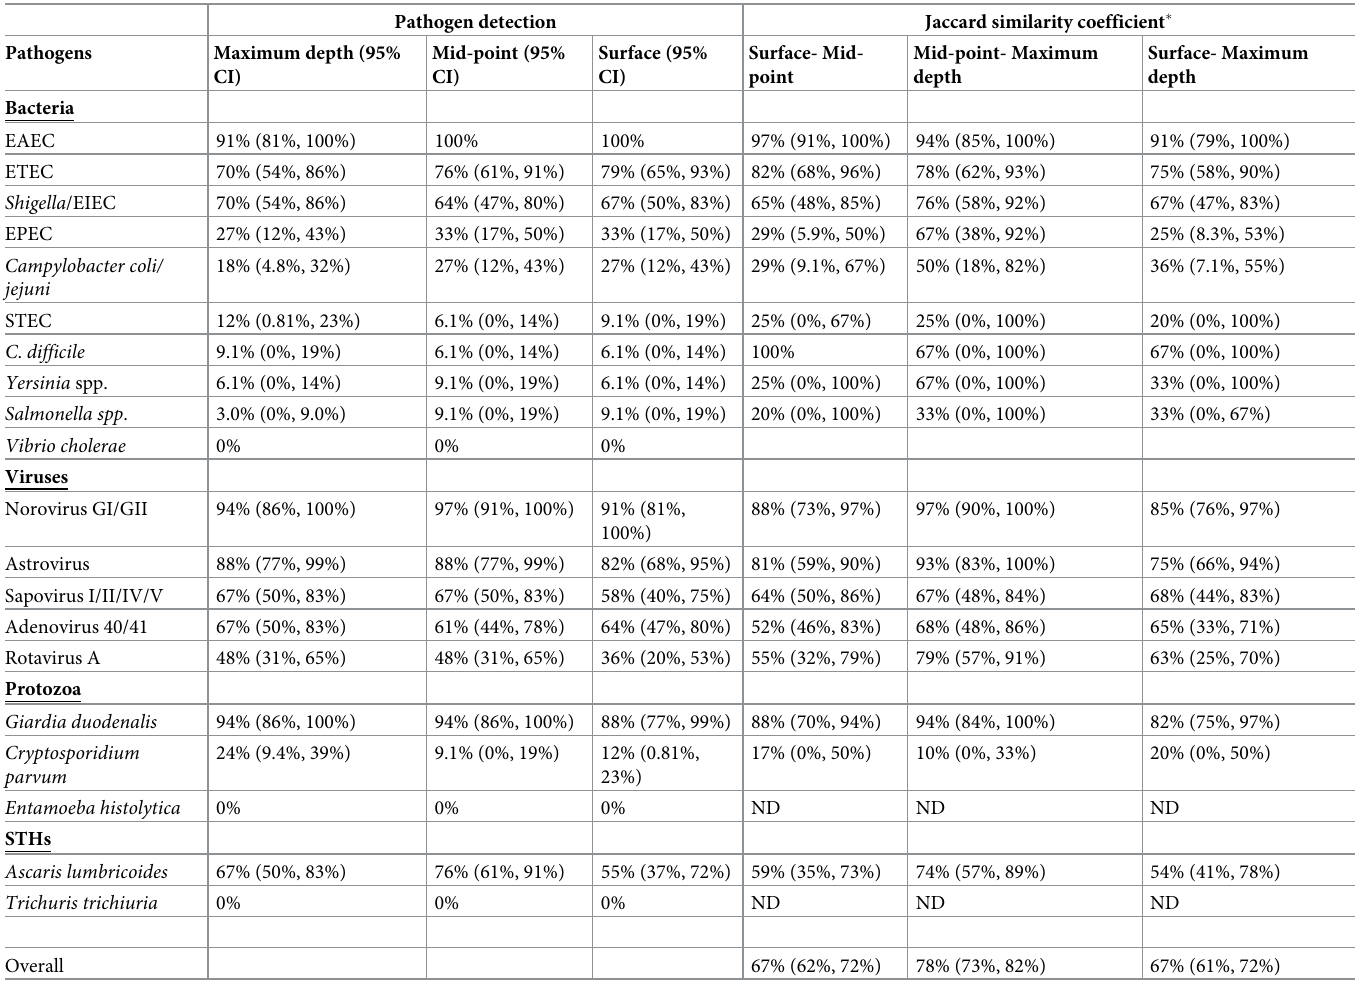
Table 2. Pathogen and indicator detection by pit latrine